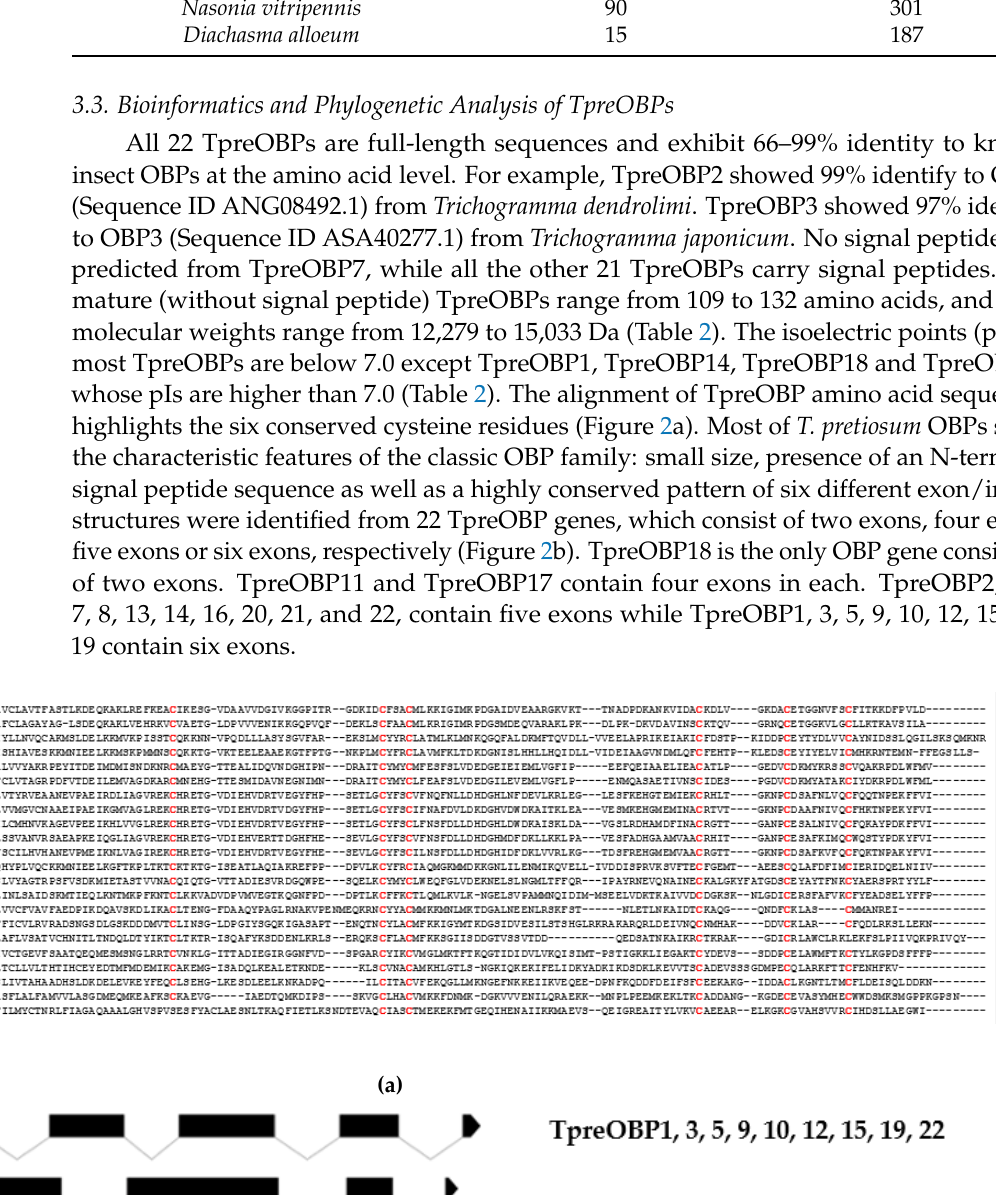
Table 1. The numbers of OBPs and ORs, in Trichogramma pretiosum , Apis mellifera, Nasonia vitripennis , and Diachasma alloeum . Species OBP OR Trichogramma pretiosum 22 Apis mellifera Nasonia vitripennis Diachasma alloeum